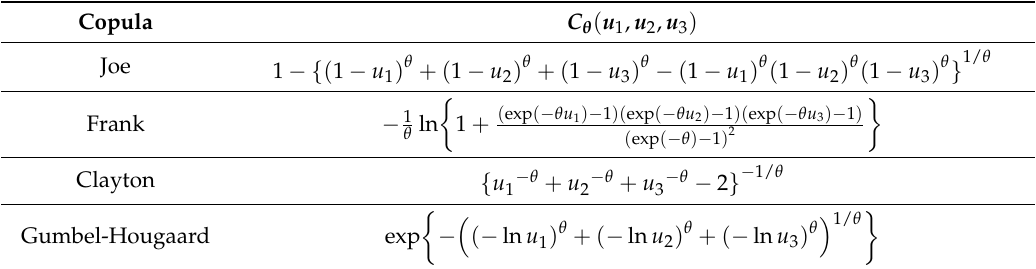
Table 1. Definitions of the selected symmetric trivariate Archimedean copulas that were used as C 1 and C 2 in Equation